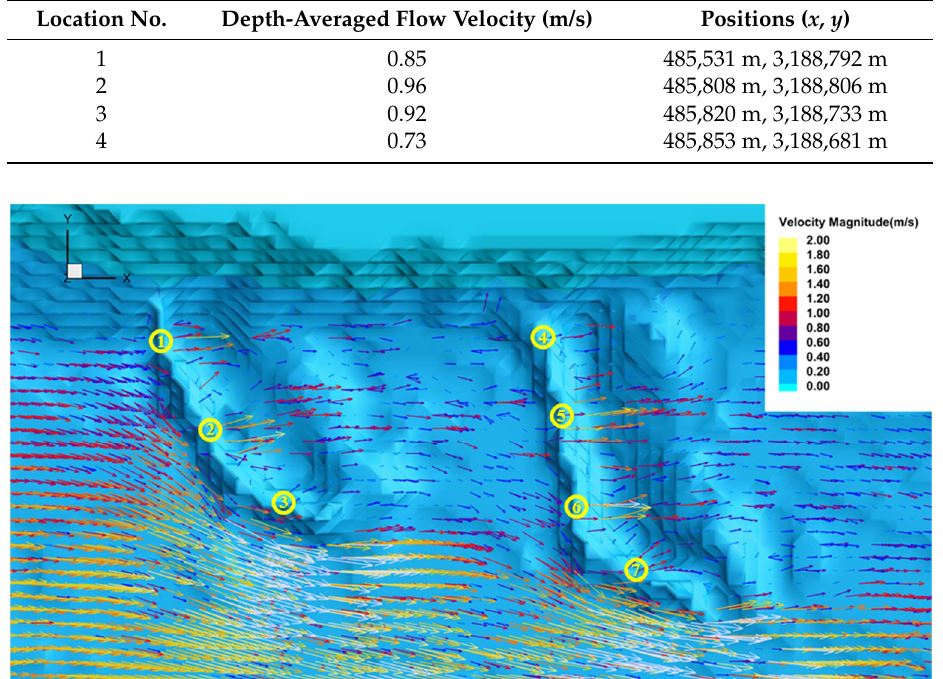
Figure 12. Potential damage positions around the double-spur dikes in totally submerged condition (top view with 3D flow field). Table 4. Flow velocity at the potential damage positions in totally submerged condition. Location No.